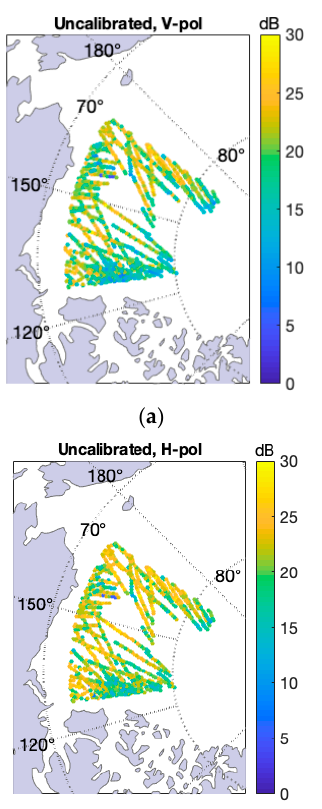
Figure 19. February 2018 SMAP-R samples as a function of the high gain antenna incidence angle: ( a ) uncalibrated and ( b ) calibrated. Note that calibrated values correspond to radar cross section values after applying calibration Equation (5), under coherent assumption.